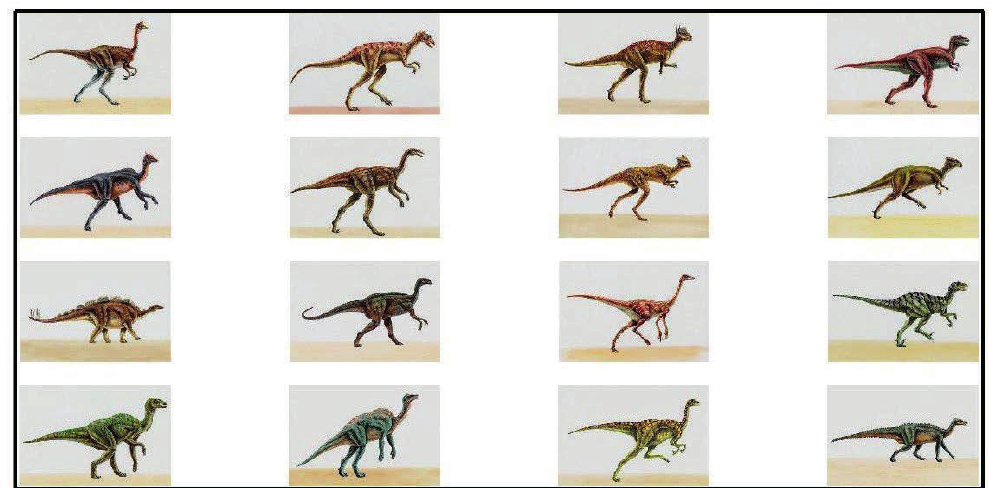
Fig. 9. Dinosaur images retrieved using CLD based